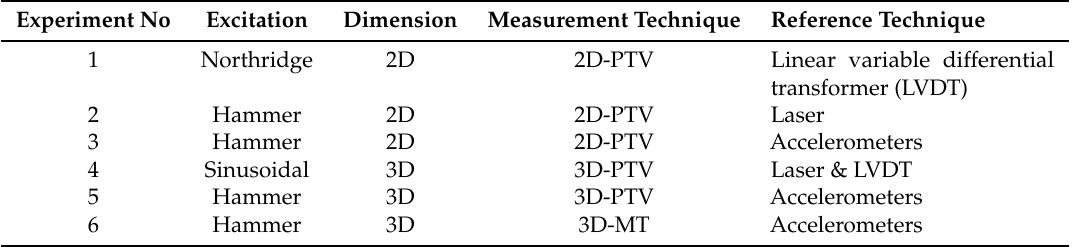
Table 1. List of experiments for different excitations and measurement techniques compared with the reference